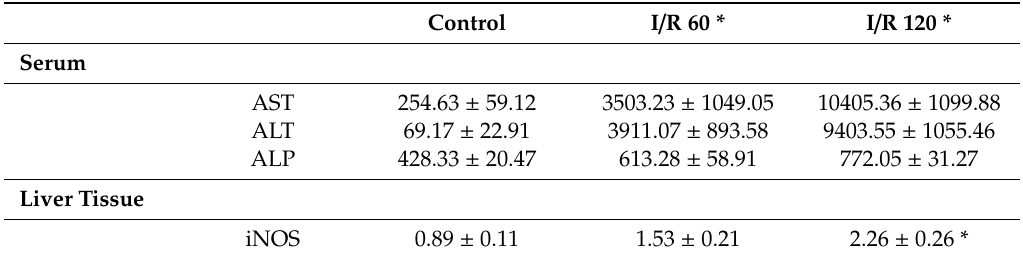
Table 1. Biomarkers of liver injury, serum levels of AST, ALT and ALP, and tissue levels of iNOS, (Means ± S.E.).